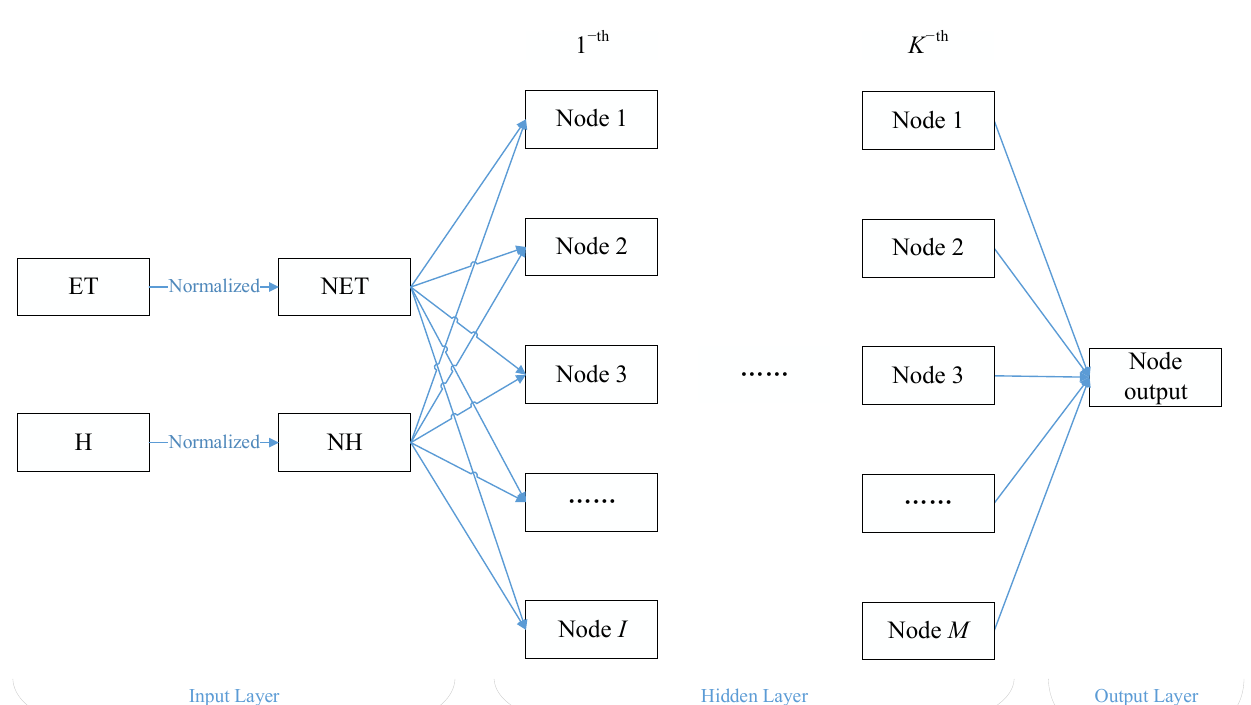
Figure 1. The schematic diagram of the Mariotte bottle system for observing the groundwater con- tribution of soybeans.